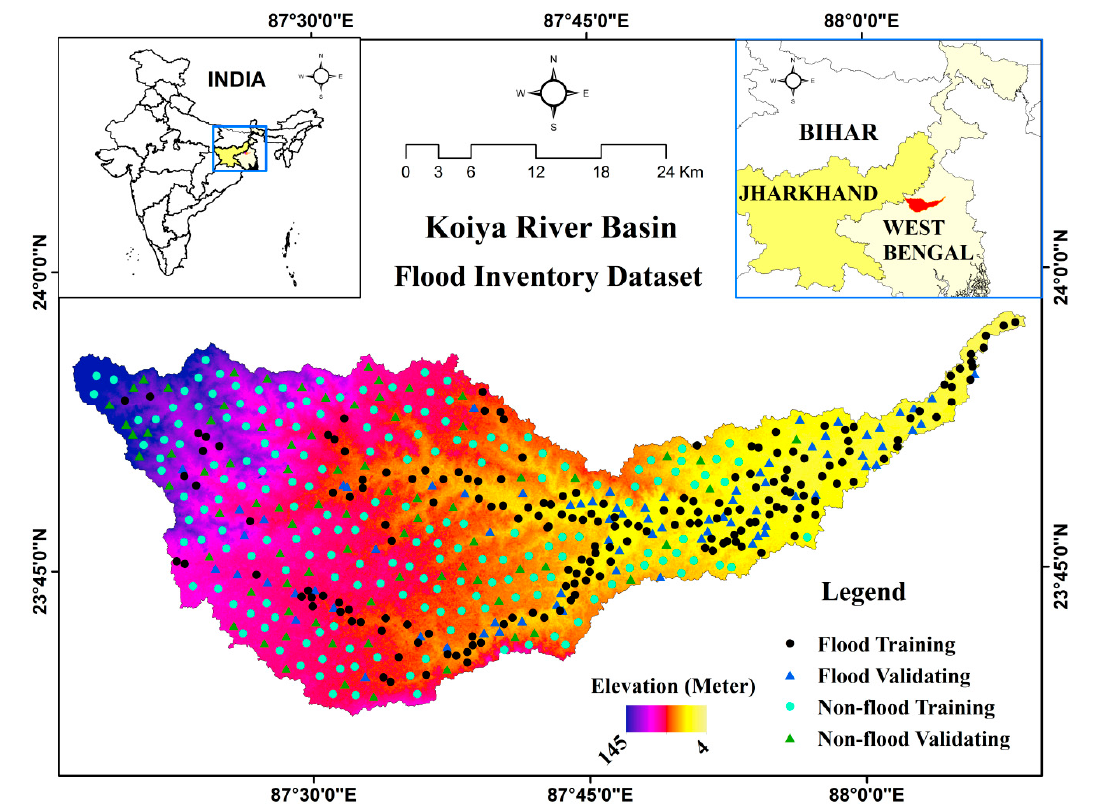
Figure 1. Location map of the study areaand flood inventory map.